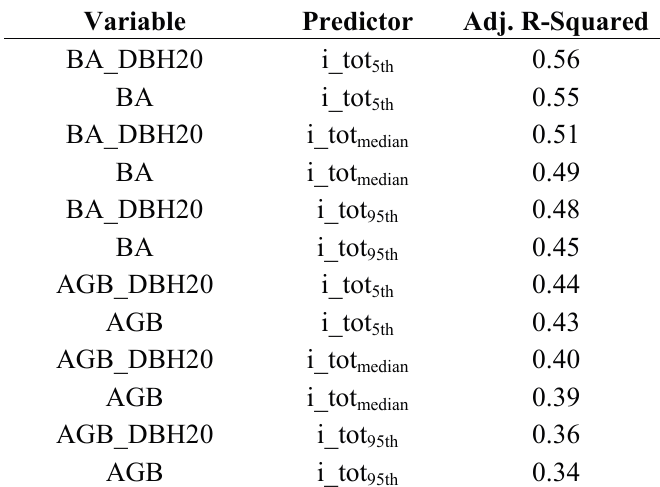
Table 5. The i_tot pulse-based metric and its R-squared values, from linear fitting AGB and BA variables, in descending order. _DBH20 = trees with a DBH equal to or above 20